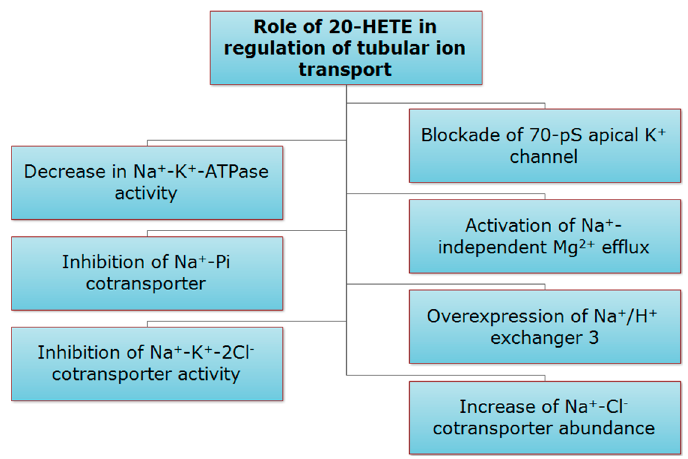
Figure 5. Role of 20-HETE in regulation of tubular ion transport. 238